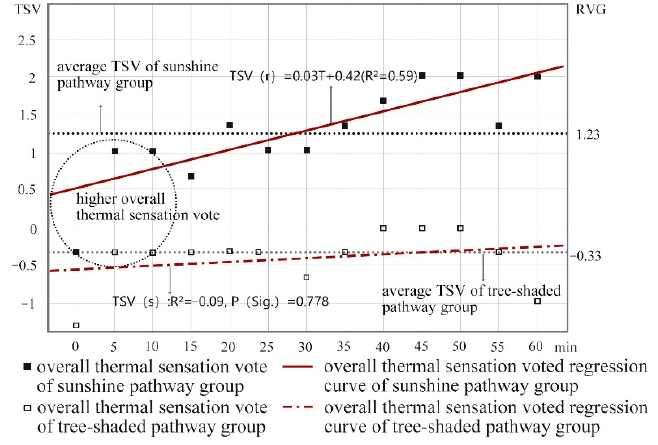
Figure 7. Voted overall thermal sensation of sunshine pathway group and tree-shaded pathway group.